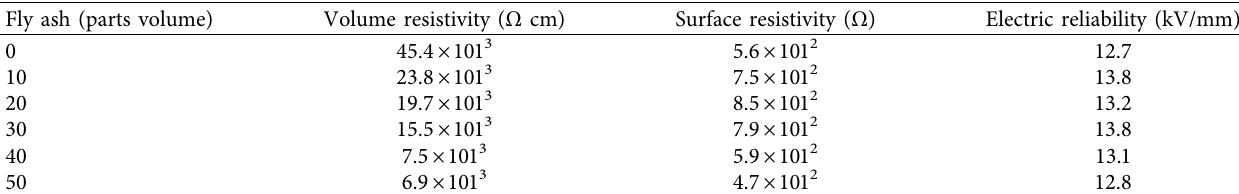
Table 4: Dielectric properties, reliability strengths, and surface resistivity of epoxy and its composites. Fly ash (parts volume)